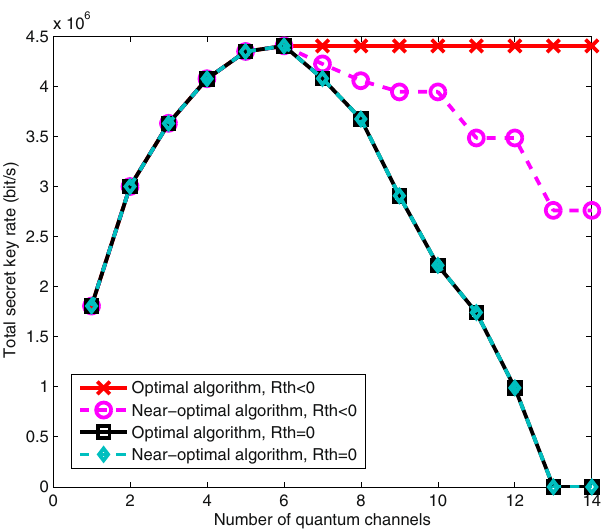
Figure 7. Comparison between the total key rate of the optimal and near-optimal methods for N = 8 and L = 62